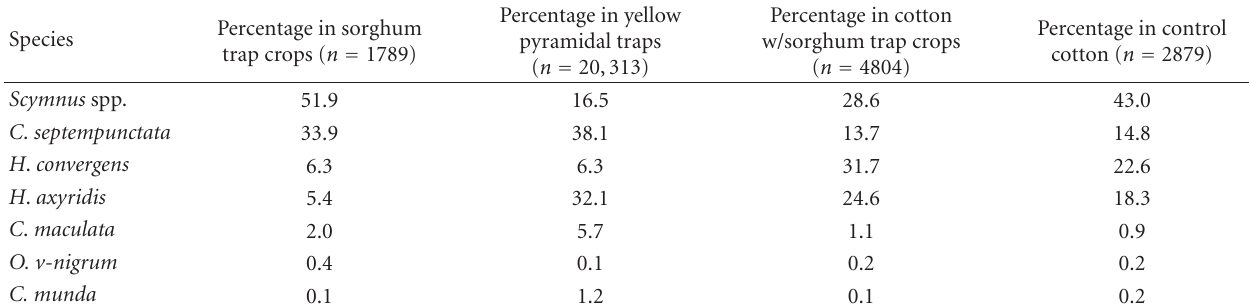
Table 2: Percentage composition (within columns) of lady beetle species in sorghum trap crops, yellow pyramidal traps, cotton with sorghum trap crops, and control cotton.